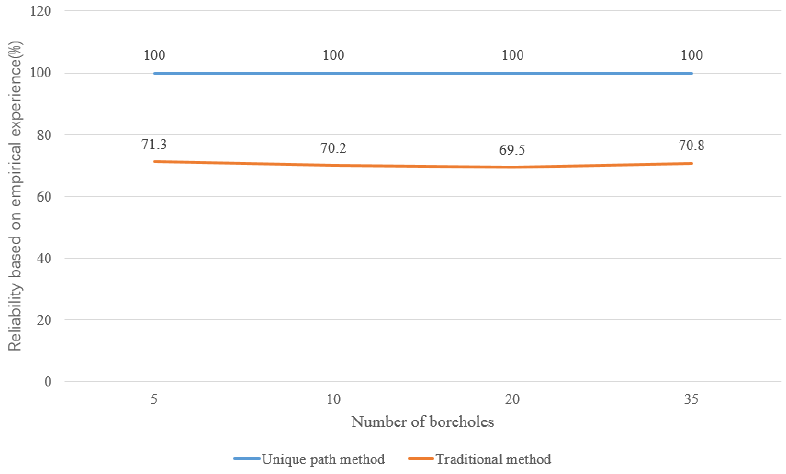
Figure 22. Comparison of reliability based on empirical experience between two methods with different numbers of boreholes.